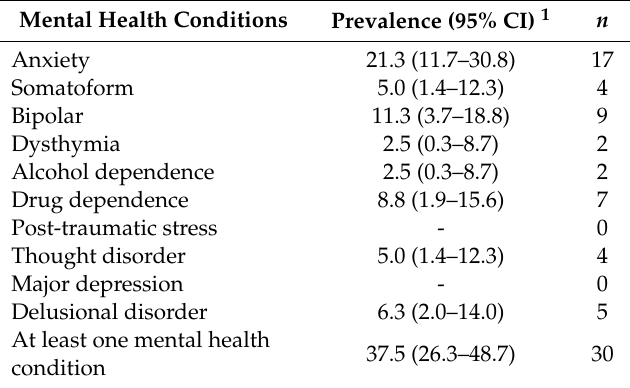
Table 2. Prevalence of mental health conditions according to the Millon Clinical Multiaxial Inventory-III ( N =